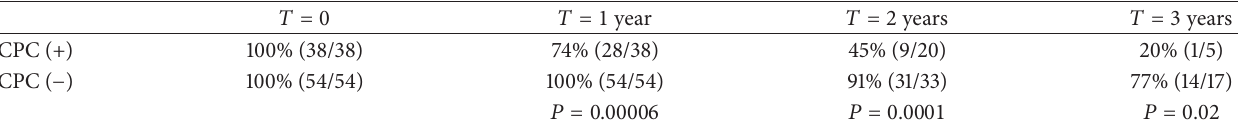
Table 6: Uncensored Kaplan-Meier of men without biochemical failure comparing CPC (+) versus CPC from time of blood